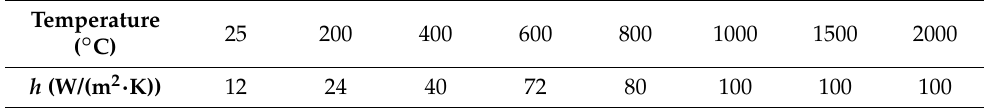
Table 5. The convection heat transfer coefficient used in the